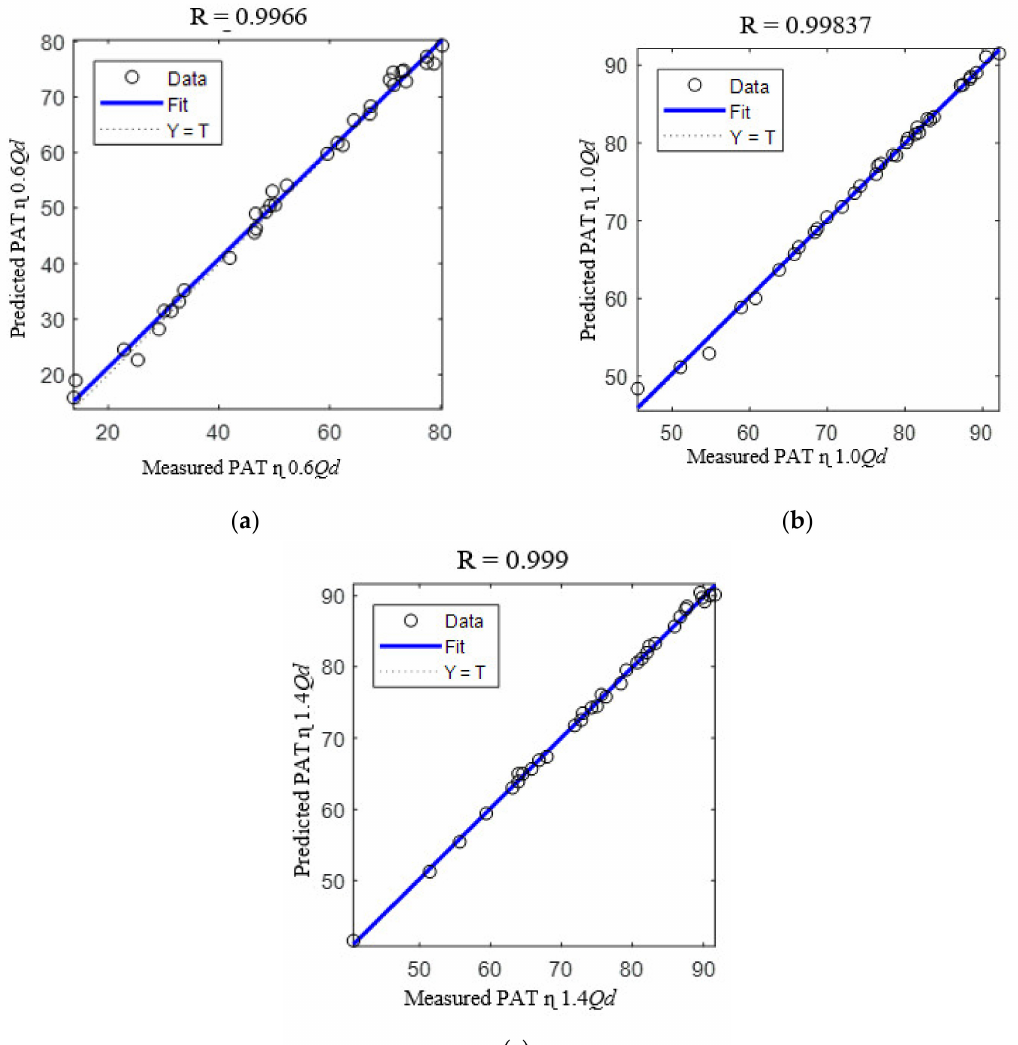
Figure 12. R-square analysis of PAT e ffi ciency: ( a ) 0.6 Q d , ( b ) 1.0 Q d, and ( c ) 1.4 Q